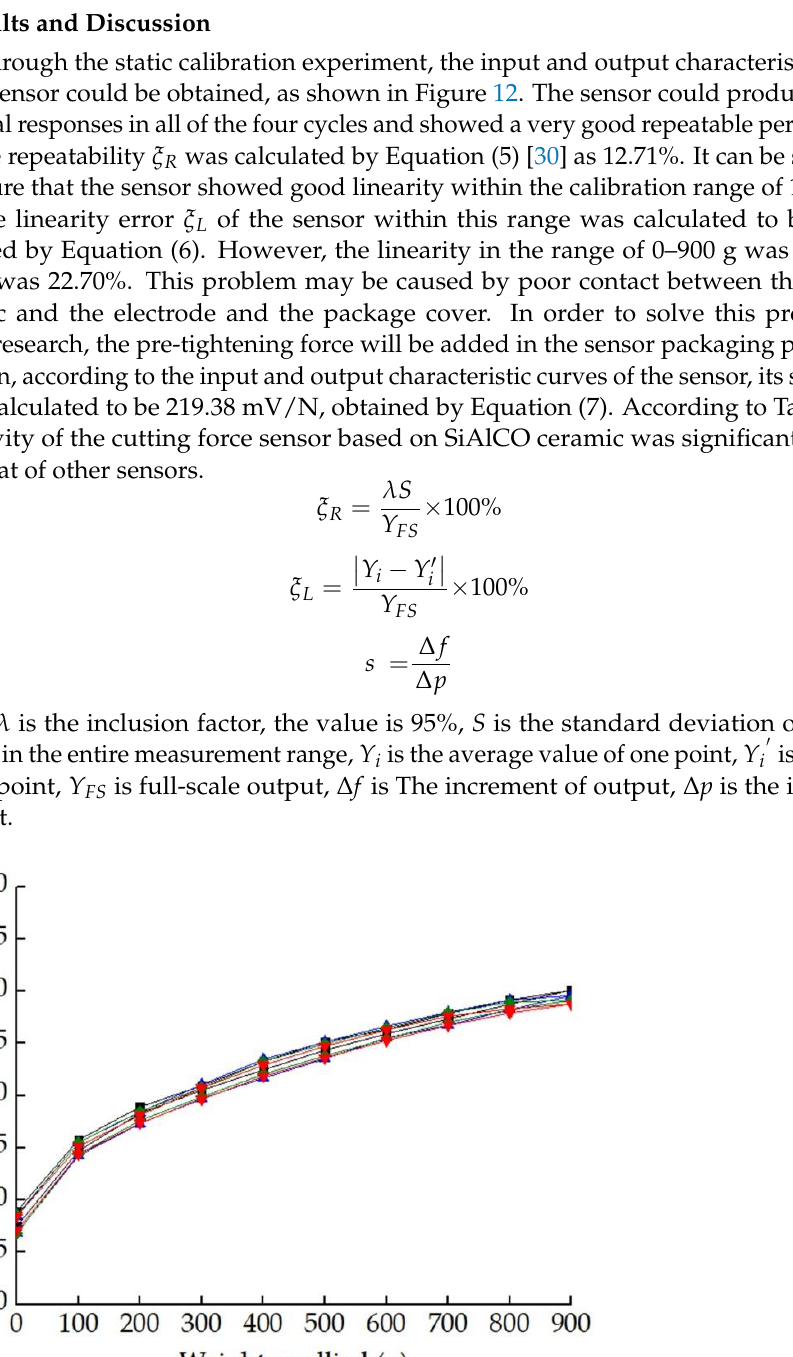
Table 1. The main parameters of the DAQ system 1 .